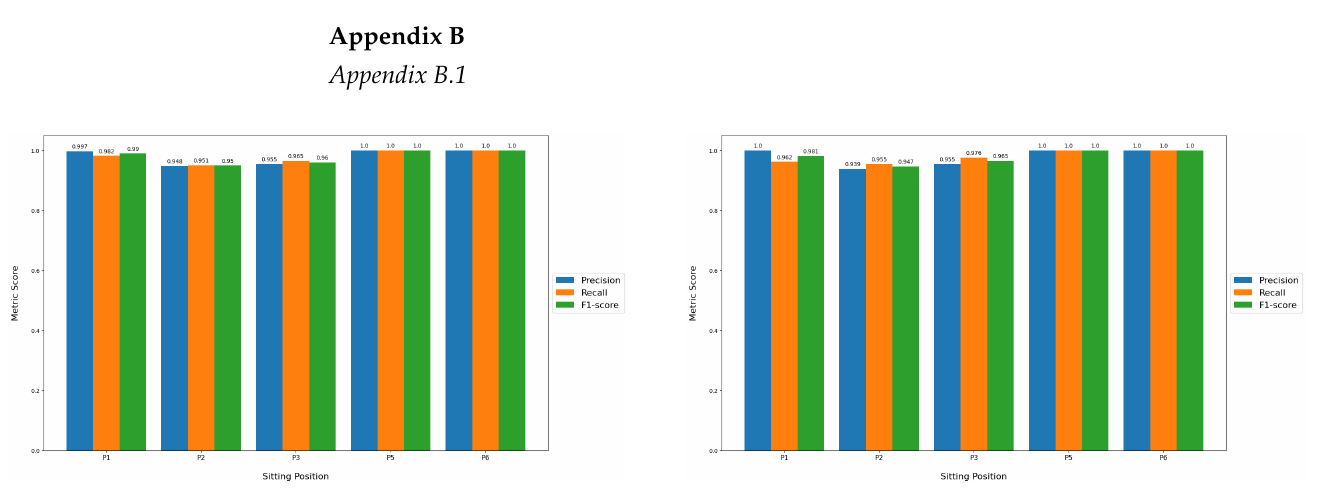
Figure A1. Label-wise precision, recall and F1-score values obtained for each